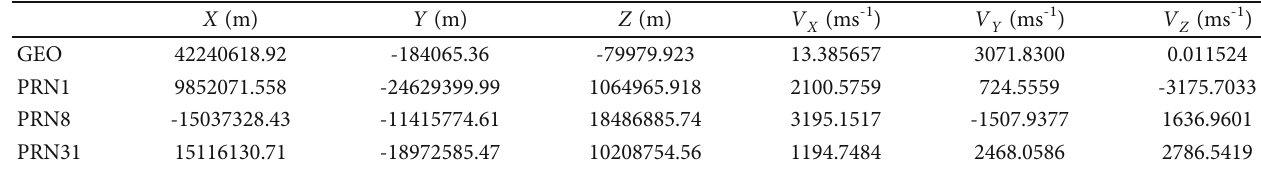
Table 1: Initial state of each satellite.